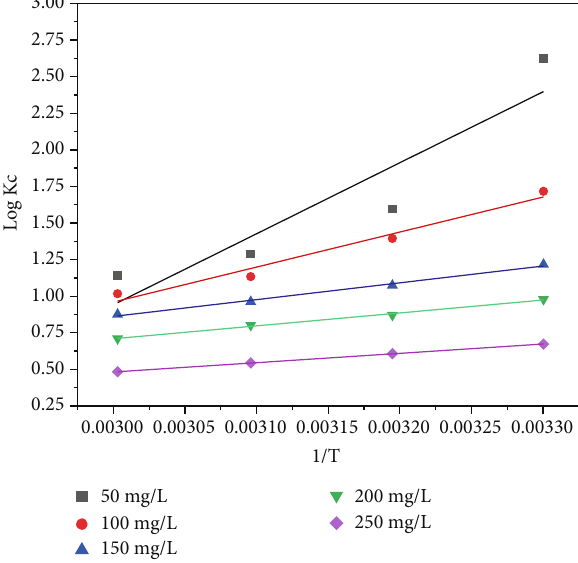
Figure 12: Thermodynamic analysis for the elimination of ARS dye by CTASP